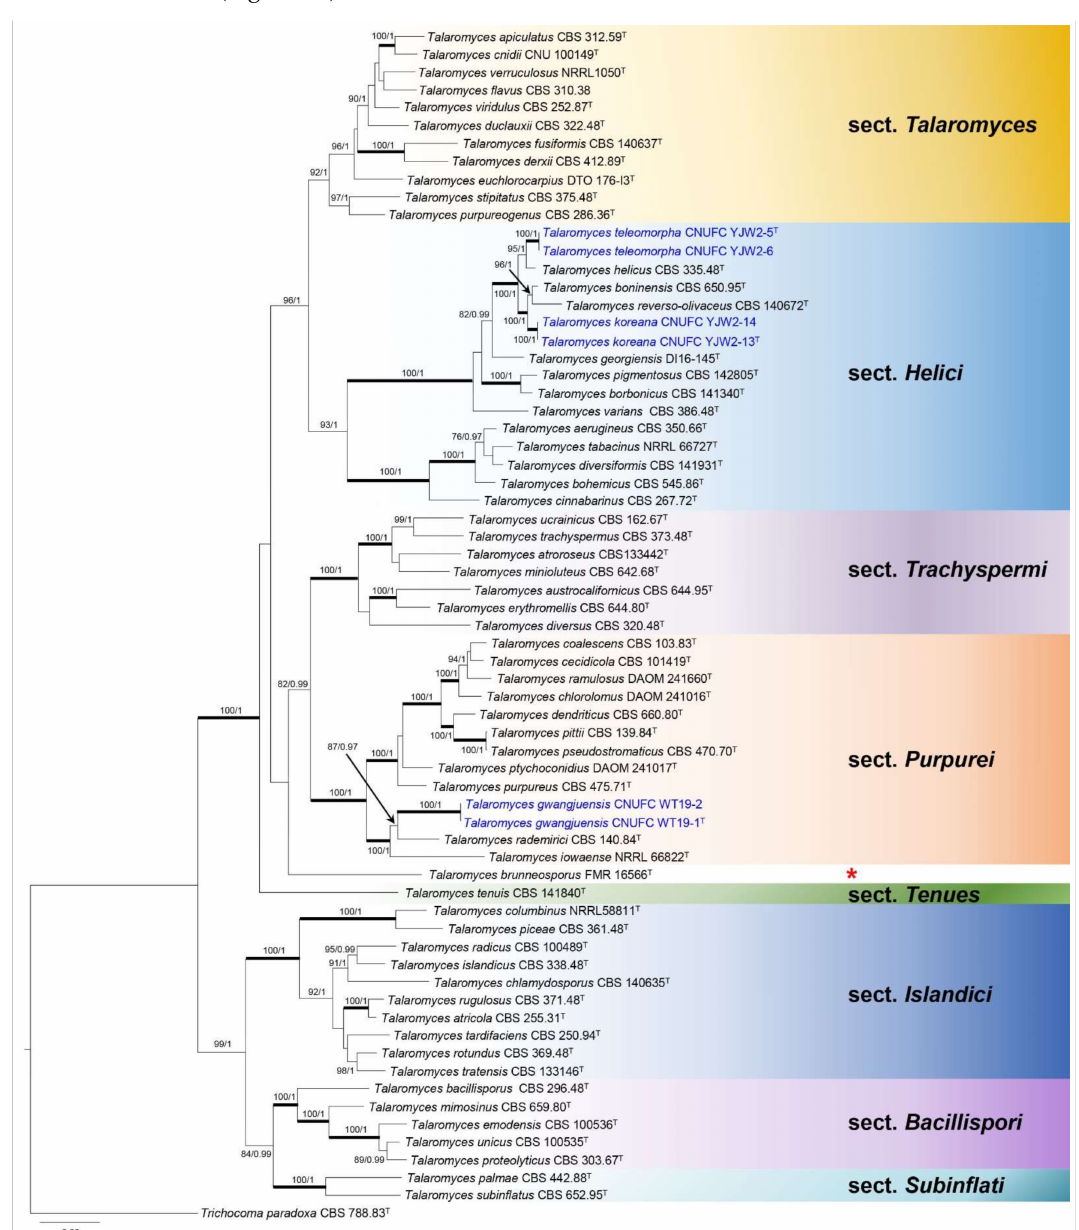
Figure 1. Phylogram generated from the Maximum Likelihood (RAxML) analysis based on the combined ITS, BenA , CaM , and RPB2 sequences data of Talaromyces . The red asterisk represents a separate lineage which is not assigned yet. The branches with values = 100% ML BS and 1 PP are highlighted by thickened branches. The branches with values ≥ 70% ML BS and ≥ 0.95 PP indicated above or below branches. Trichocoma paradoxa CBS 788.83 was the group was used as the outgroup. The newly generated sequences are indicated in blue. T =